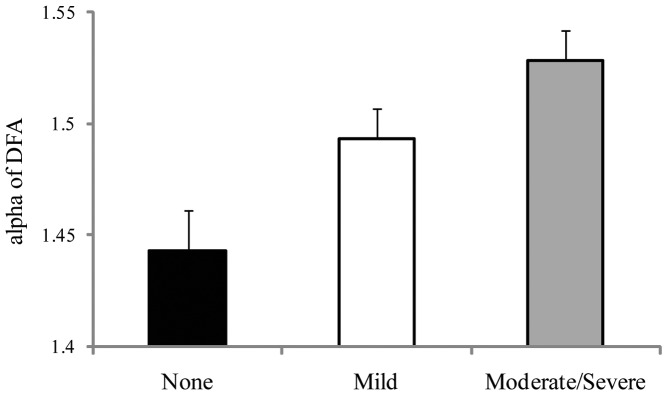
Experiment 3: Meanα of DFA on Day 0 (before the voyage began) for the three seasickness severity groups.The figure illustrates the statistically significant effect of seasickness severity groups. The error bars represent standard error of the mean.